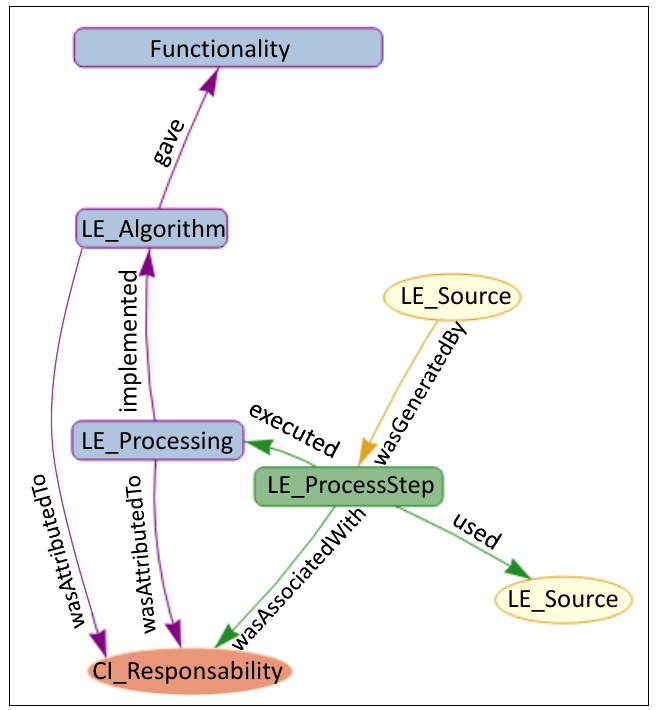
Figure 3. How the use of PROV relates the lineage ISO elements.